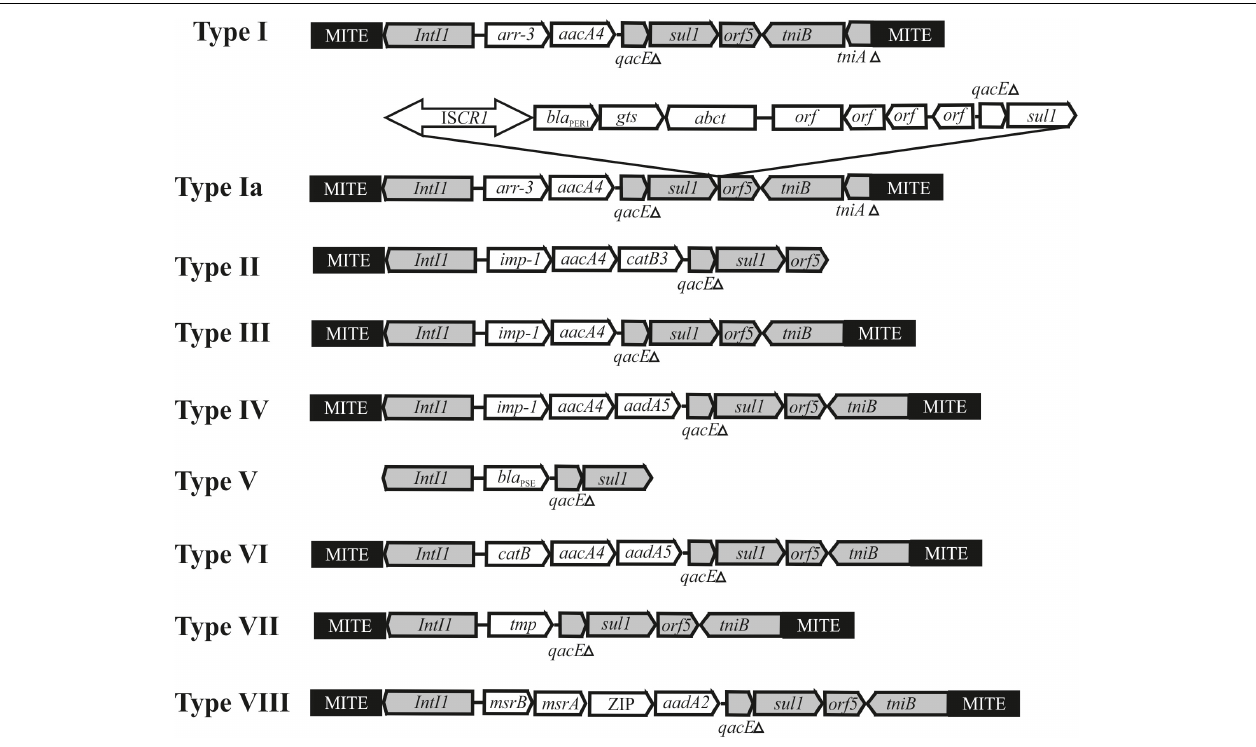
FIGURE 4 | Genetic structure of integrons found in Acinetobacter mega-plasmids belonging to the group III-4a. The location and polarity of genes are shown with arrows. The conserved regions of integrons: 5 (cid:48) -conserved segment—intI1-integrase and 3 (cid:48) -conserved segment— qacE (cid:49) , sul1 , orf5 , tniB , tniA (cid:49) . Cassette genes: arr3 —rifamycin-resistance; aacA4 , aadA2 and aadA5 —aminoglycoside resistance; catB , catB3 —phenicols resistance ; bla PSE —beta-lactam resistance; imp-1 —metallo- β -lactamase, msrA and msrB —peptide methionine sulfoxide reductase, ZIP-cation transport. MITE–a miniature inverted-repeat transposable elements facilitating mobilization of integron by transposition. Other elements: IS CR1 - bla PER − 1 contains gene bla PER − 1 encoding